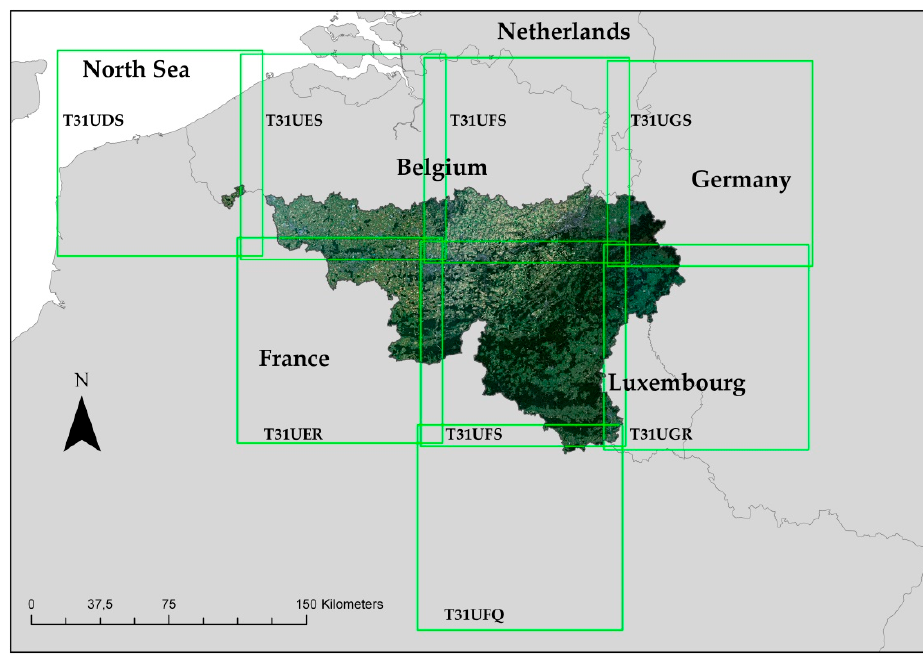
Figure 2. Tiles arrangement allowing the realization of the three mosaics of Sentinel-2 in Wallonia, Belgium. Eight tiles (T31UDS, T31UES, T31UFS, T31UGS, T31UER, T31UFS, T31UGR, and T31UFQ) were used to produce three mosaics. The data spanned from December 2016 (winter mosaic), March to May 2016 (spring mosaic), and July to September 2016 (summer mosaic). The mosaics were cloud-free and characterized by a uniform leaf-on state of the trees. Table 1. The dates of the images used to produce the three mosaics (winter, spring, and summer 2016).